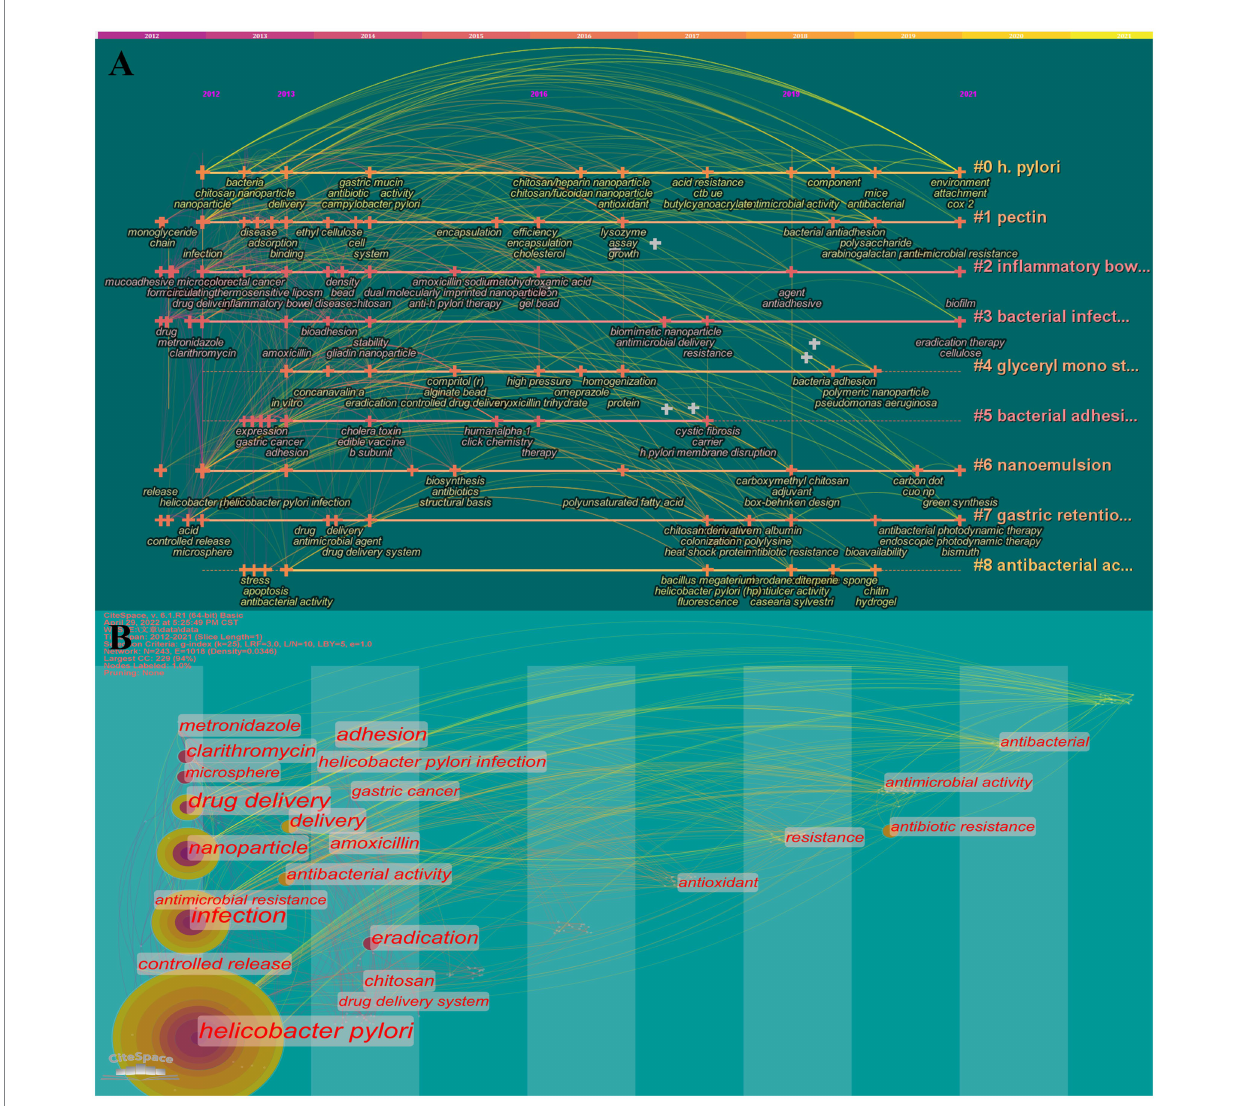
FIGURE 6 Timeline (A) and timezone (B) of keywords. 11 clusters are shown in A, and each is labeled with the tag #. The smaller the number, the more keywords are included in the cluster. Each node represents a keyword, and the time when the node appears indicates the time when the keyword emerged. The line between nodes indicates the relationship between keywords and the continuity in